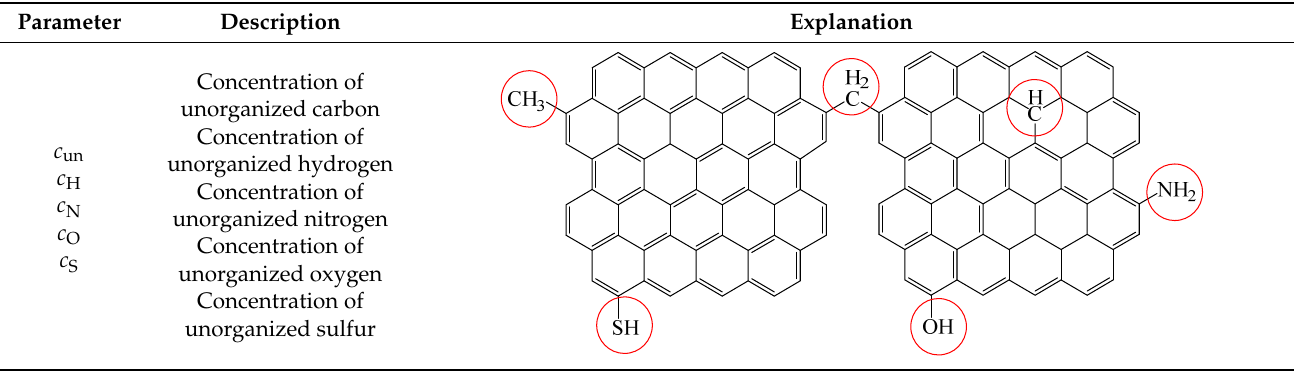
Table 3. NGCs can contain non-organized carbon ( sp 3 hybridized) or foreign atoms (e.g., H, N, O, S). It must be assumed that these atoms are also non-organized and cause only background scattering.